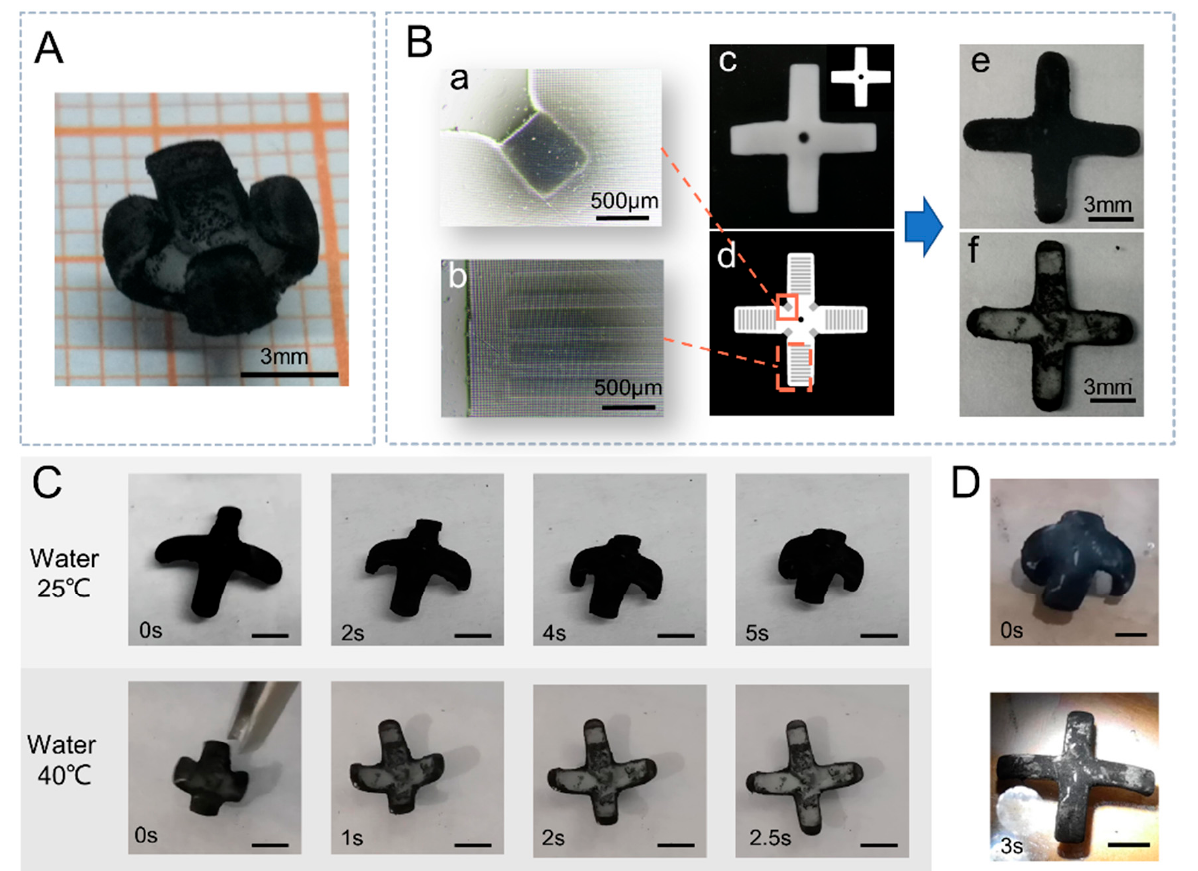
Figure 4. ( A ) Normally closed micromanipulator. ( B ) Multilayer structure of the micromanipulator. ( c ) The deformation layer of the manipulator with the photomask pattern of the fabrication process in the upper right corner. ( d ) The photomask pattern of the rigid layer with the arrangement of gray values to guide the direction of deformation. ( a , b ) Photographs of the optical microscope of the rigid layer. ( e ) Photograph of the deformation layer side of the bilayer structure of the micromanipulator. ( f ) Photograph of the rigid layer side of the micromanipulator. ( C ) Deformation behavior of the micromanipulator driven by temperature (Scale bar is 3 mm). ( D ) Deformation of the light-driven micromanipulator (Scale bar is 3 mm).